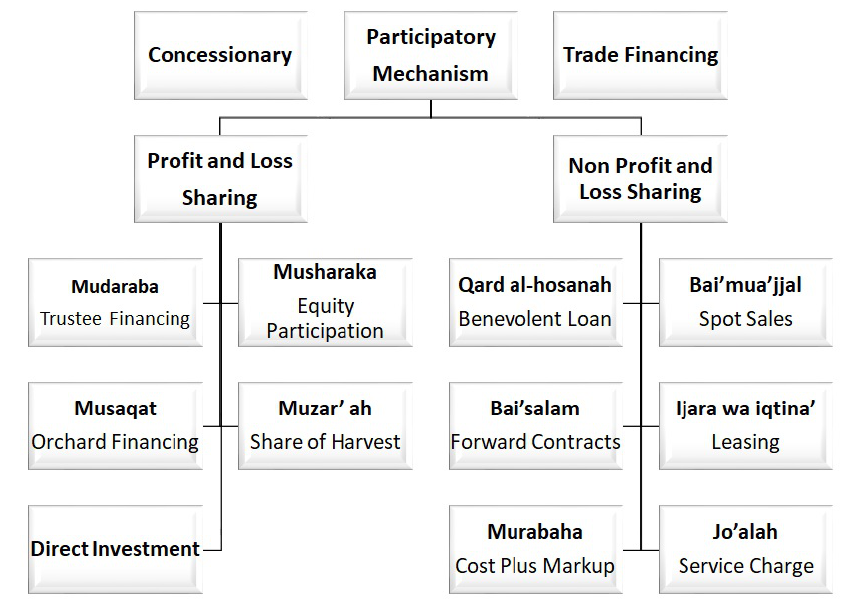
Figure 1. Types of Islamic financial contracts, authors’